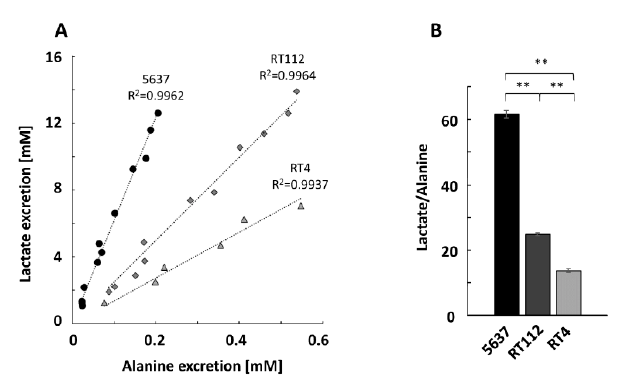
Figure 3. In vitro measurement of the lactate / alanine ratio. ( A ) Correlation graphic between lactate and alanine excretion for the three cell lines: 5637 (circles), RT112 (rhombuses), RT4 (triangles). ( B ) Slope values of the lactate / alanine correlation lines. ** p < 0.01.